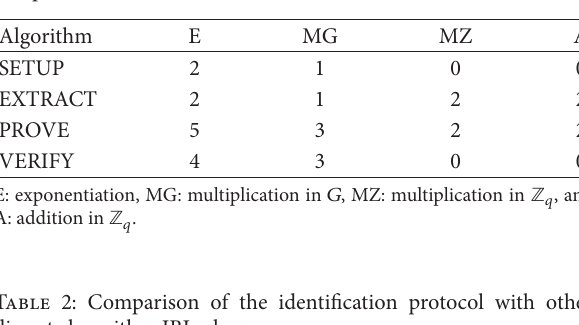
Table 1: Efficiency of the Twin-Schnorr-IBI Scheme without pre- computation.